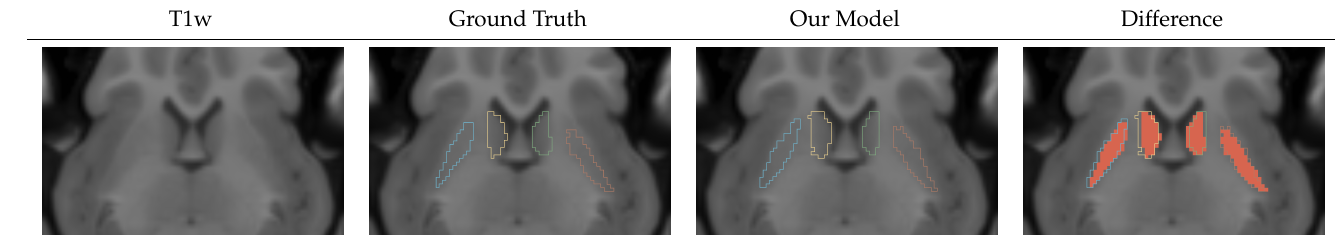
Figure 4. Caudate-putamen segmentation mask visualization. The difference image shows the ground truth mask in red with the color outline of our model prediction. The mask generated by our model closely resembles the manually traced ground truth